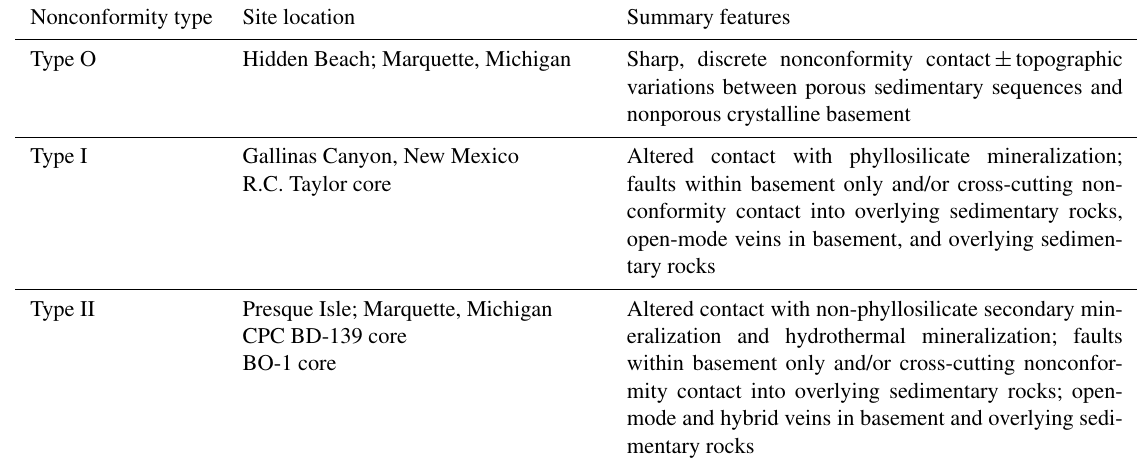
Table 1. Summary of nonconformity types and associated